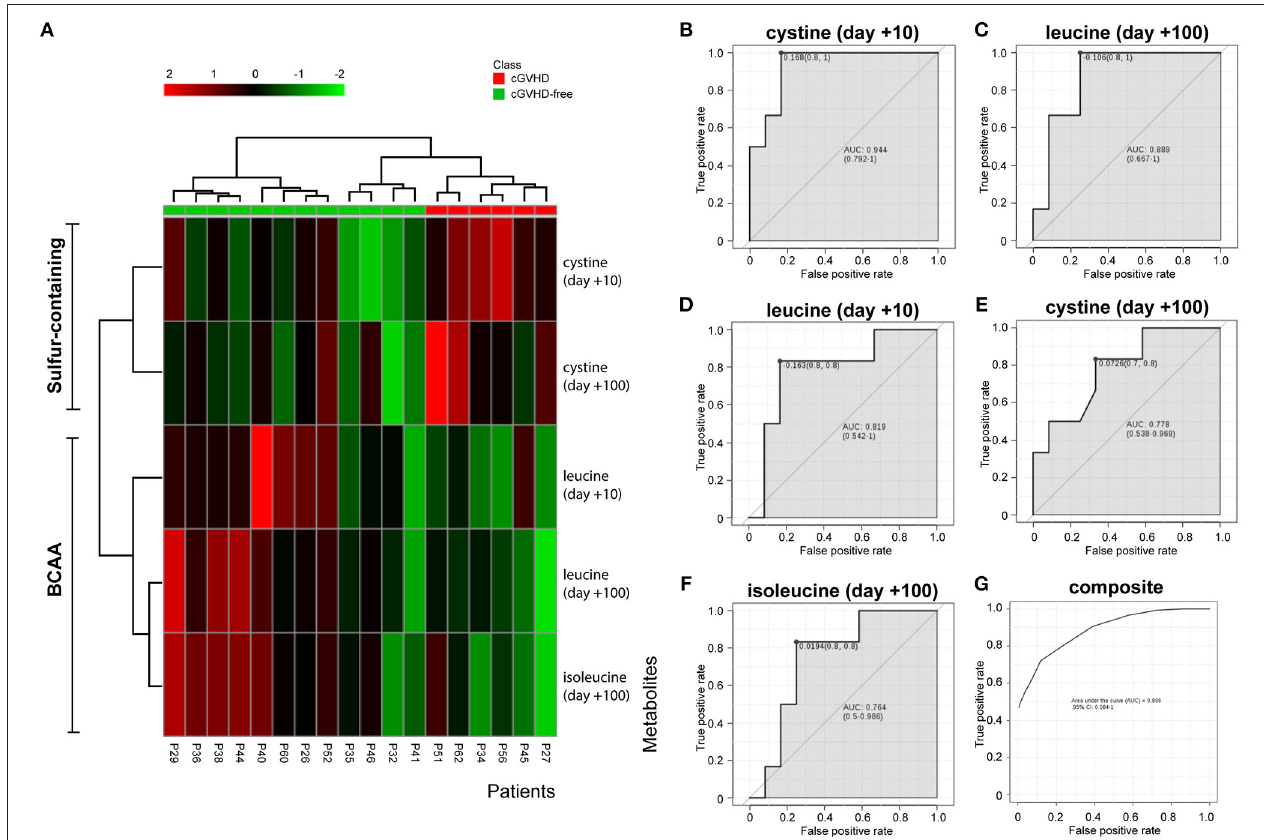
FIGURE 3 | BCAA and cystine cluster cGVHD patients from patients without cGVHD. Clustering analyses and biomarker potential of 3 metabolites in 2 data points in the discovery cohort. (A) Heatmap generated by cystine and leucine auto-scaled concentrations at day + 10 and day + 100 and isoleucine at day + 100. (B–F) Individual receiver operating characteristic (ROC) curves of metabolites and (G) composite ROC curve of the metabolite panel.